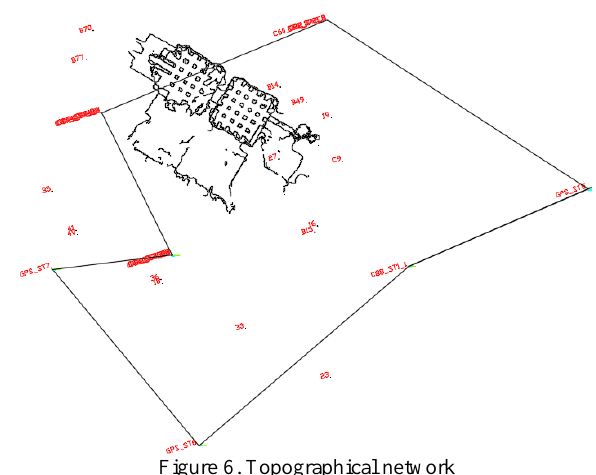
Figure 6. Topographical network